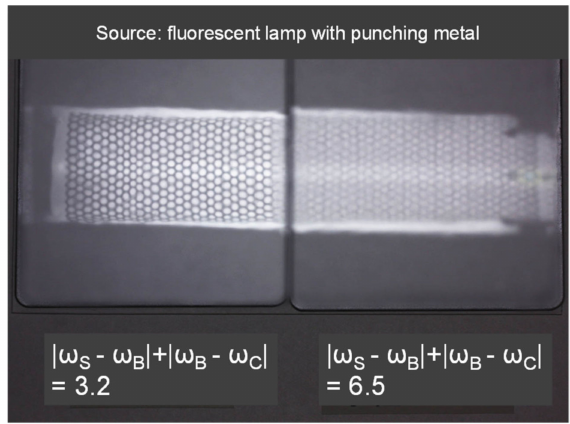
Figure 14. Image of coating surface of two panels (left;| ω S − ω B | + | ω B − ω C | = 3.2, right;